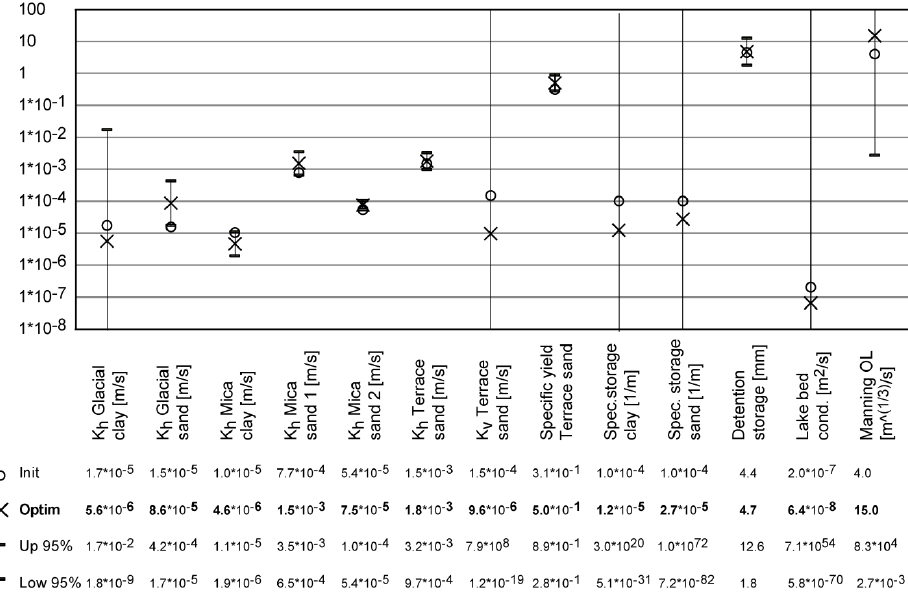
Fig. 6 Optimized, initial and calculated 95% confidence limits of parameter values by PEST optimisation.